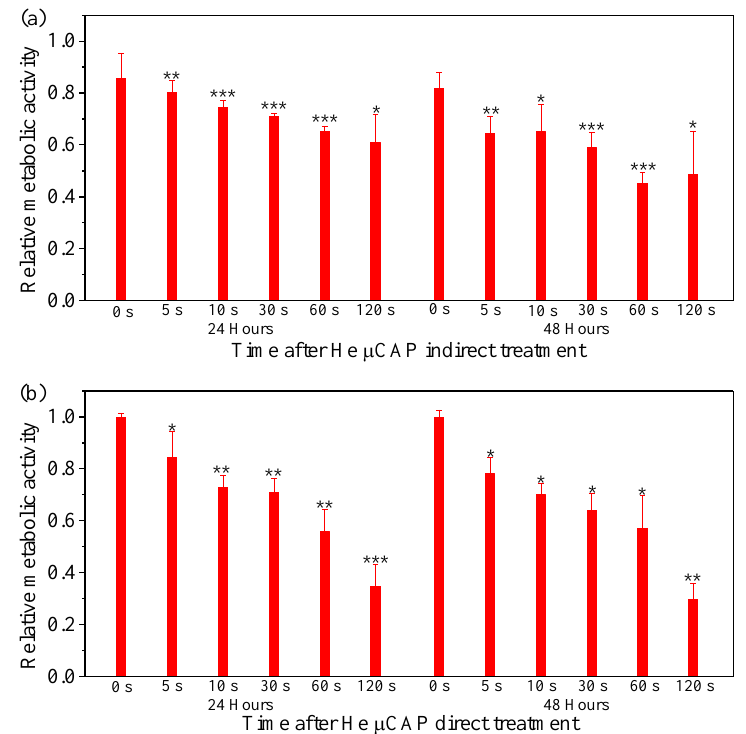
Figure 6. Cell viability of U87MG after 24 and 48 hours of incubation with He µCAP indirect treatment ( a ) and direct treatment ( b ) for 0, 5, 10, 30, 60, and 120 s. The ratios of surviving cells for each cell line were calculated relative to controls (0 s) in DMEM. Student t -test was performed, and the statistical significance compared to cells present in DMEM (0 s) is indicated as * p < 0.05, ** p < 0.01, *** p < 0.001. ( n = 3).